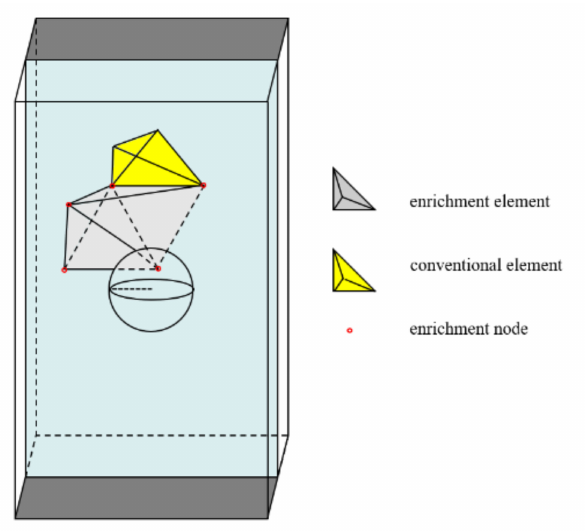
Figure 1. Enrichment elements in 3D tetrahedron elements.